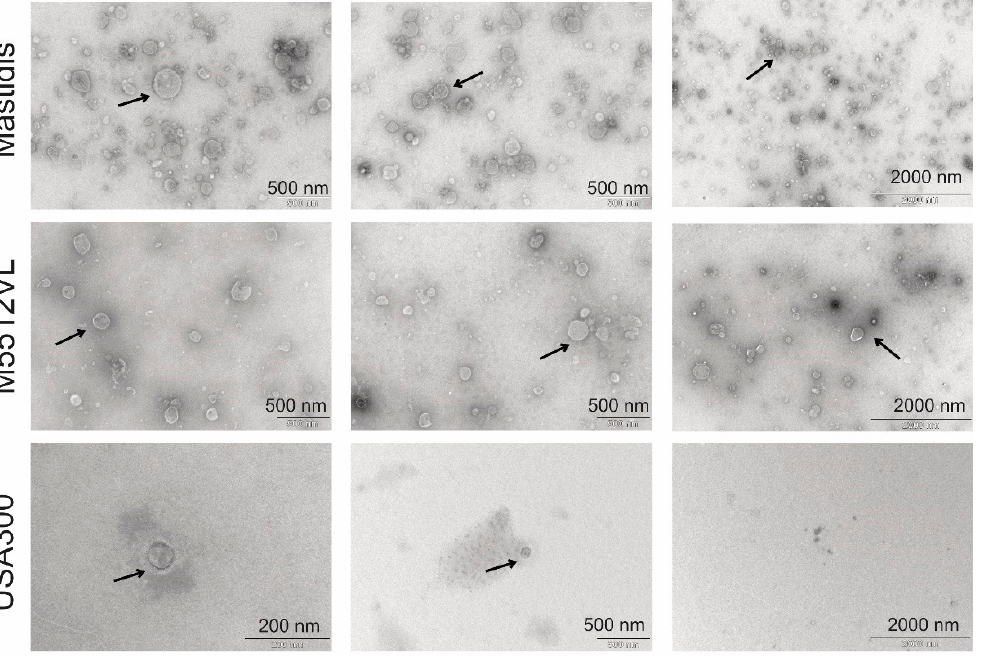
Figure 1. Transmission electron microscopy (TEM) observations of isolated S. aureus EVs for each mastitis strain Mastidis, M5512VL, USA300, N305 and M5702. Black arrows indicate EVs. 3.2. EVs from S. aureus M5702 and M5512VL Contain Alpha-Haematoxylin (Hla) Western blot showed that not all S. aureus strains produced EV with Hla, and only M5702 and M5512VL presented a band at the expected position of 36 kDa (Figure 2b). Importantly, these bands were only seen in the ultracentrifuged pellet and not in the cul- ture media (Figure 2b). We also found a strong band at 50 kDa, likely due to the unspecific binding of the secondary antibody by staphylococcal protein A (Figure 2c).